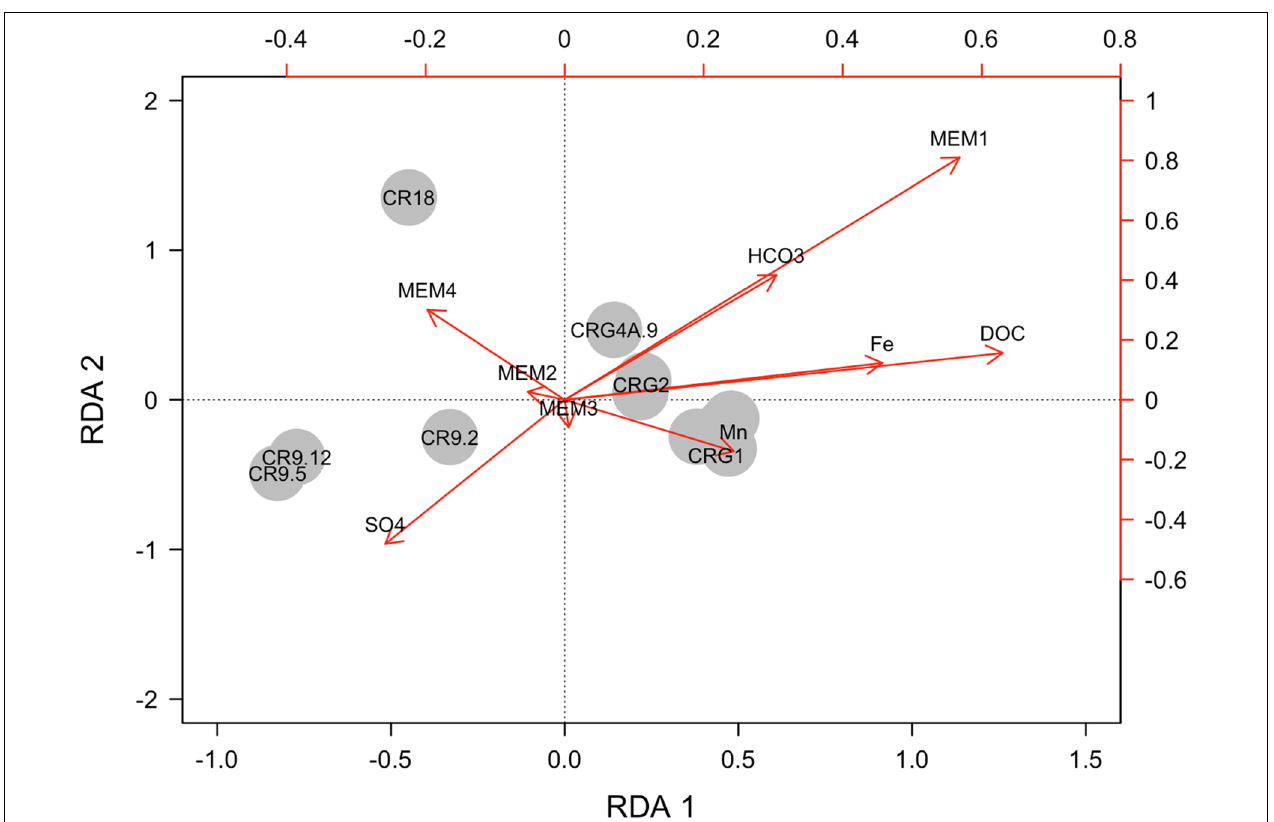
FIGURE 6 | Explanatory power of selected environmental and spatial variables on taxa abundances. The axes are the first and second coefficients from the redundancy analysis (RDA). Global adjusted R 2 of 29.4%. The sampling locations are labeled according to the borehole and interval used to access the groundwater.